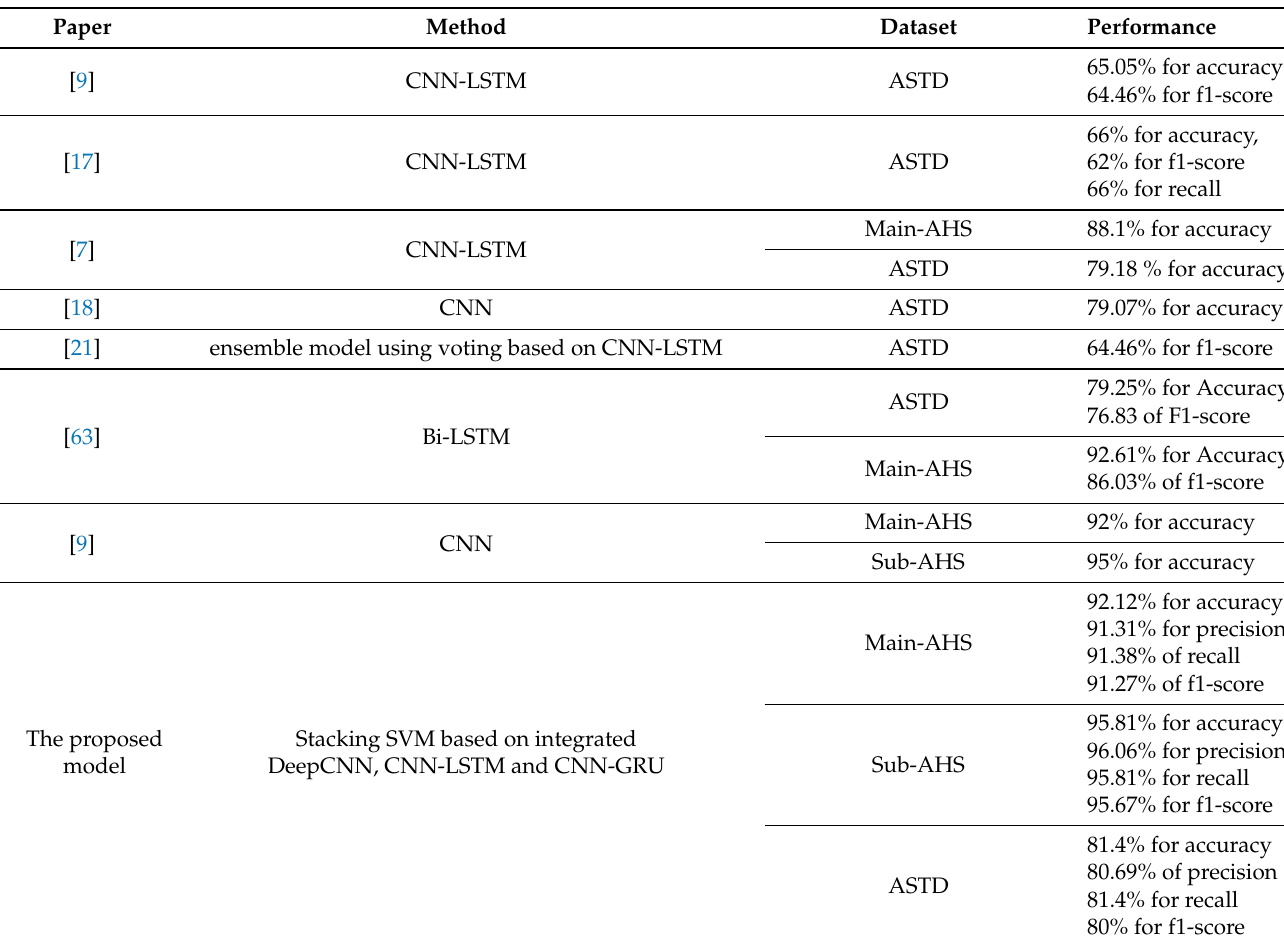
Table 7. Comparison of previous studies and the proposed